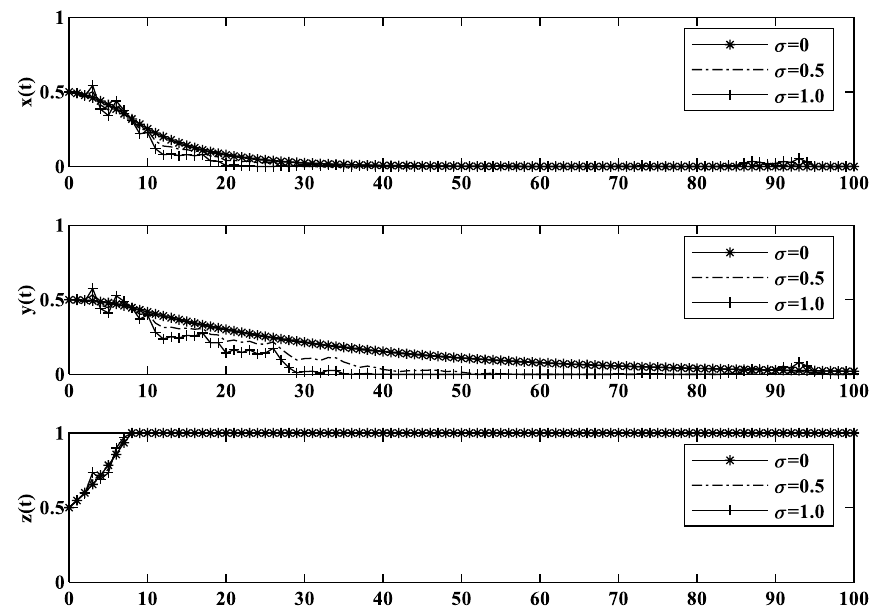
Fig. 9 Impact of disturbance intensity on evolutionary process under scenario